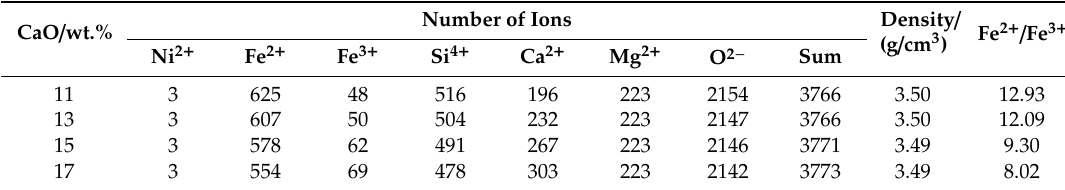
Table 1. Particle composition of molecular dynamics simulation of nickel slag. CaO / wt.%